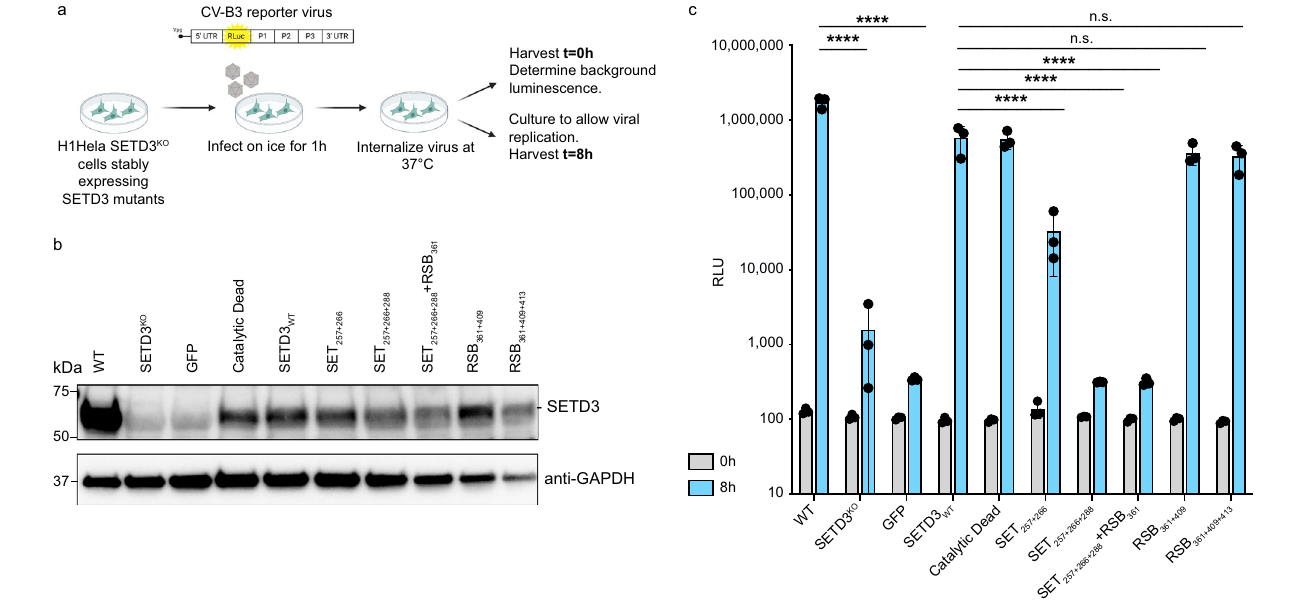
Fig. 5 | 2A binding at the SET interface is required for viral infection. See also Supplementary Fig. 7. a Schematic of synchronised luciferase-expressing CV-B3 (MOI1)infection.GraphiccreatedwithBioRender.com. b Westernblotanalysisof H1-Hela WT, SETD3 KO or SETD3 KO cells complemented with SETD3 variants under a minimal promoter are shown. c . Infection of WT, SETD3 KO or SETD3 KO cells complemented with SETD3 structure-derived mutants. n =3 biologically